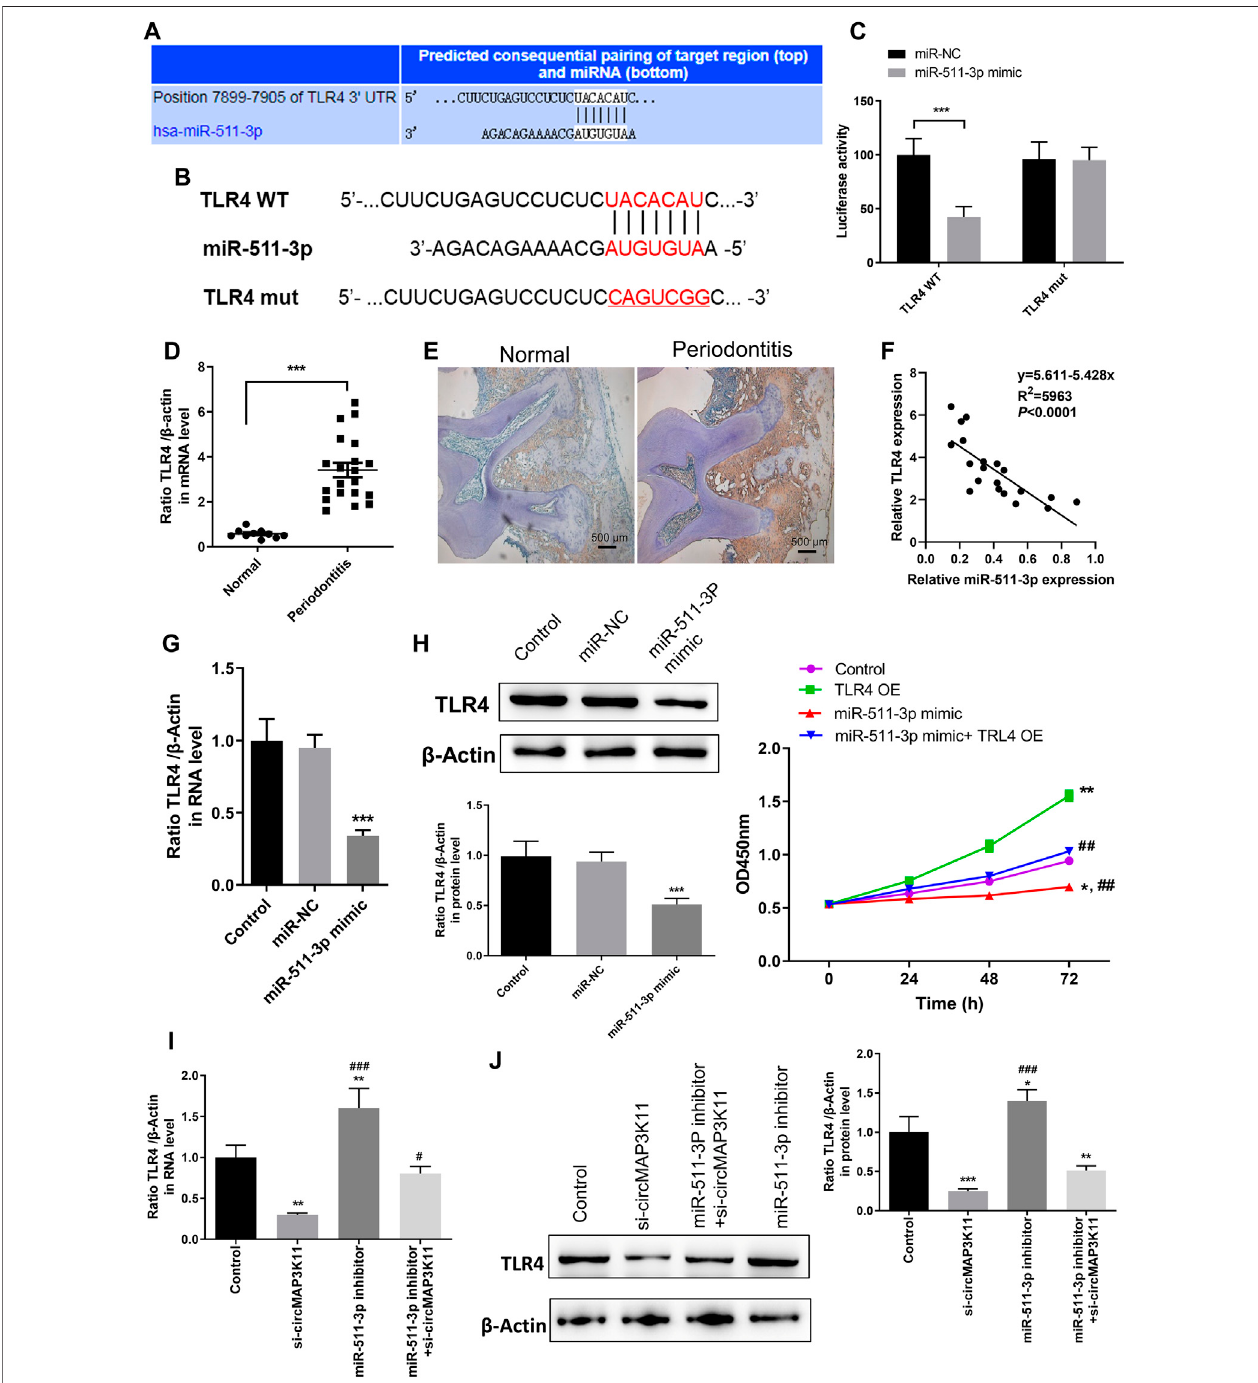
FIGURE 4| miR-511-3p is involved in periodontitis by modulating TLR4, and silencing circMAP3K11 (si-circMAP3K11) reverses the effect ofmiR-511-3p inhibitor on TLR4 expression in PDLSCs (A) The putative complementary binding sites within TLR4 and miR-511-3p predicted by TargetScan (B) The binding sites of